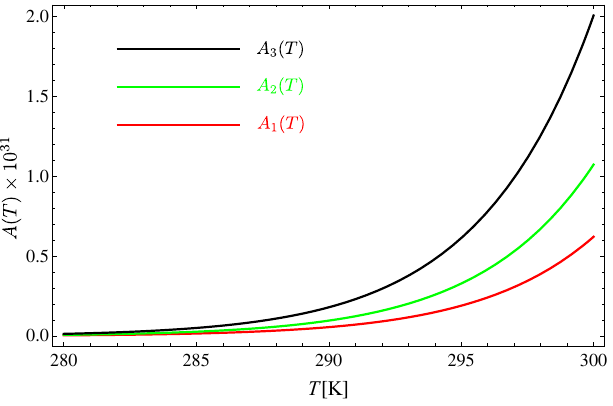
Figure 7. Renormalizing factors A j ( T ) defined in Equation (32).